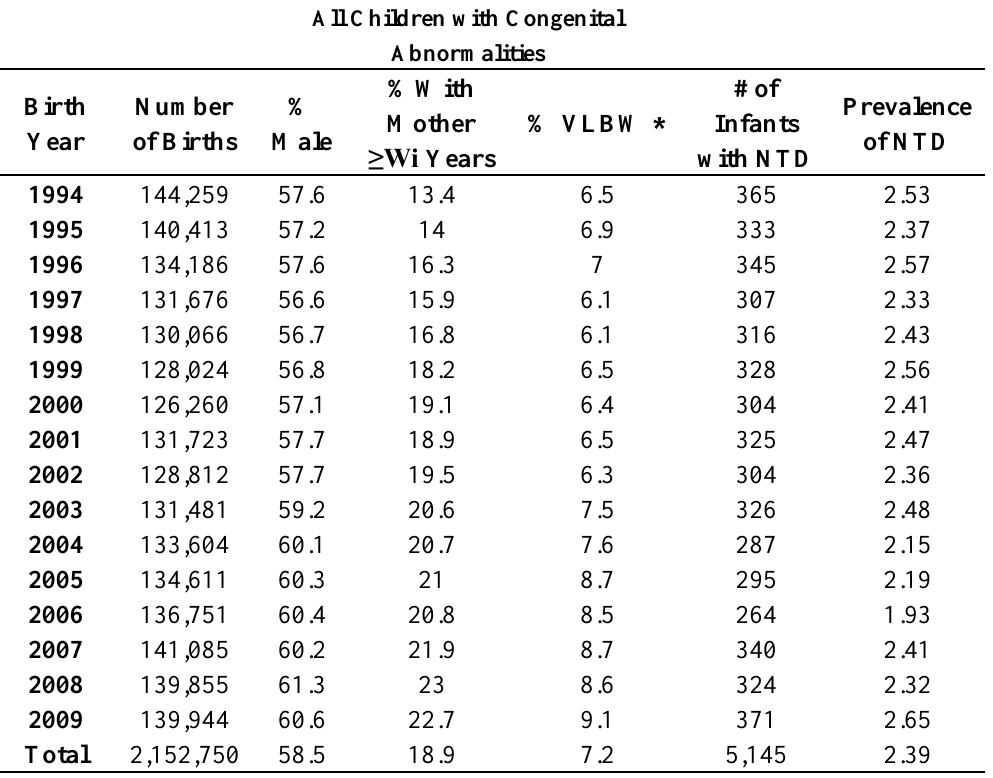
Table 1. Birth prevalence (/1,000) of Neural Tube Defects (NTD) in Ontario, 1994  2009. All Children with Congenital